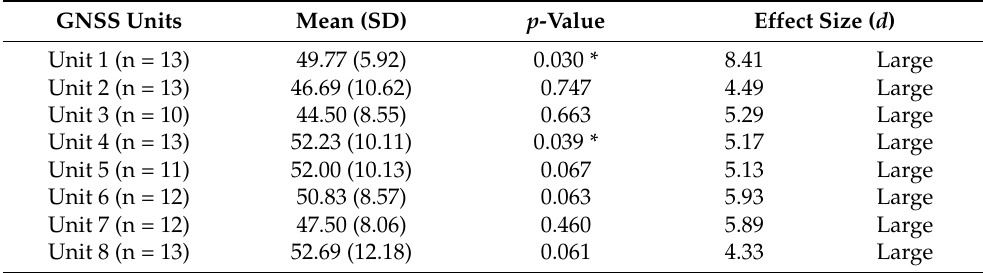
Table 2. Validity of GNSS distance measurements against known distance of 45.72 m.